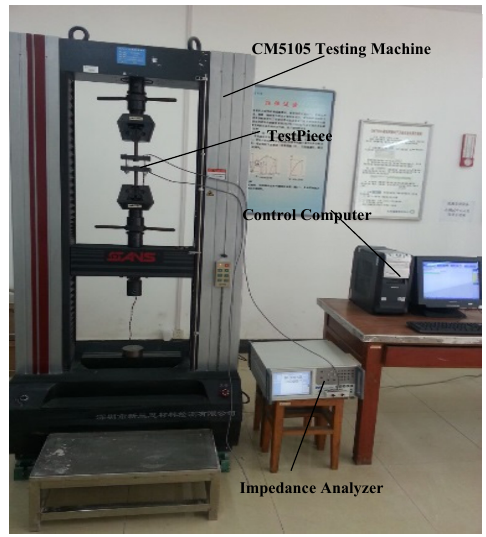
Figure 2. Testing device.